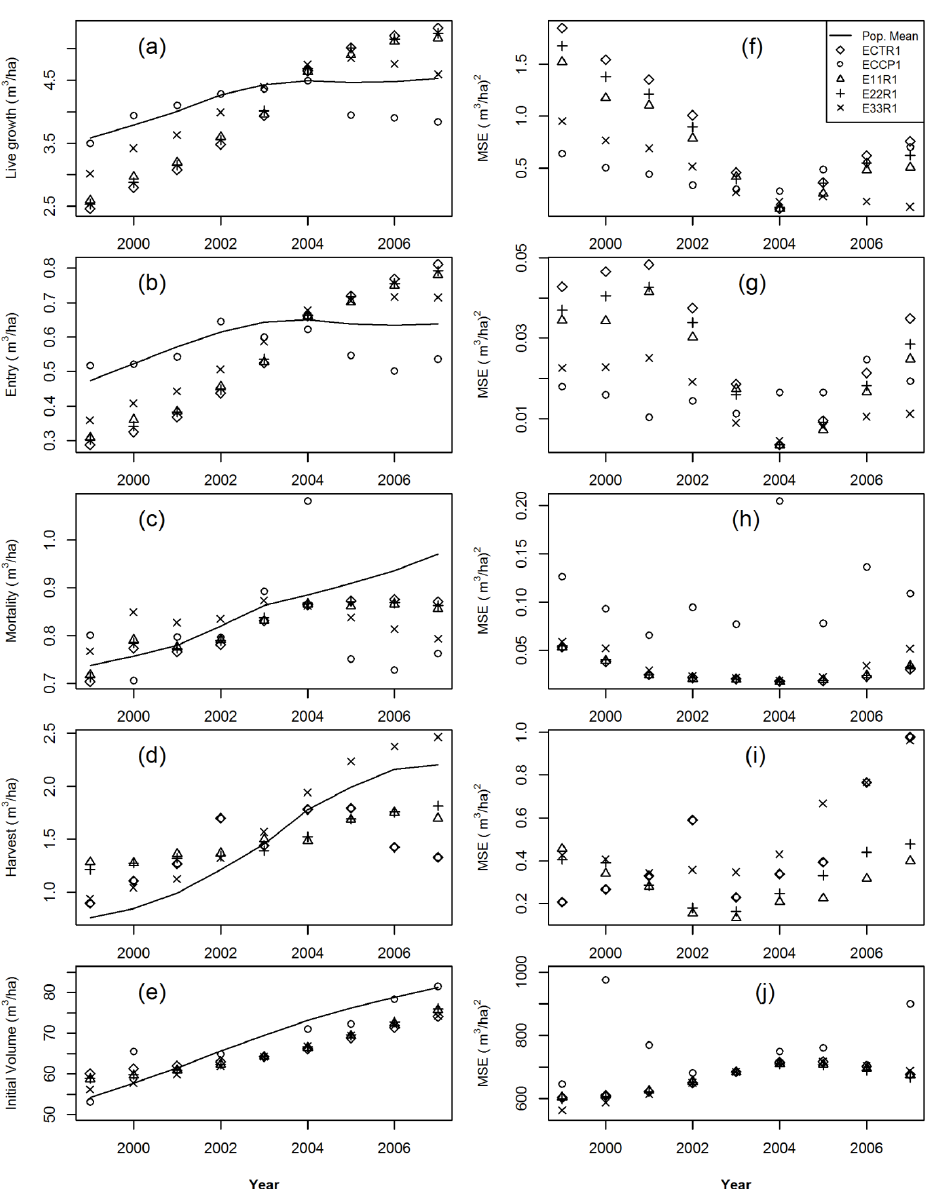
Figure 1. The empirical means of the initial annual estimators (ECTR1, ECCP1, E11R1, E22R1 and E33R1) plotted with the true population mean for ( a ) live growth; ( b ) entry; ( c ) mortality; ( d ) harvest; and ( e ) initial volume; and the corresponding mean squared errors for ( f ) live growth; ( g ) entry; ( h ) mortality; ( i ) harvest and ( j ) initial volume, from the simulation of 1000 iterations of 1000 samples each under Sample Error Structure